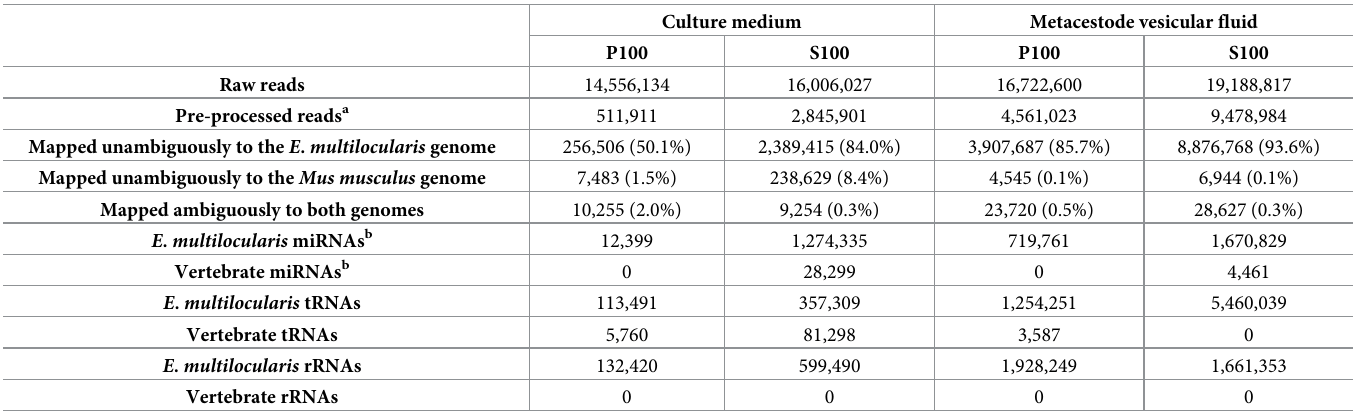
Table 1. General results of small RNA sequencing of ex-RNAs present in culture medium and metacestode vesicular fluid of active culture from E . multilocularis . Culture